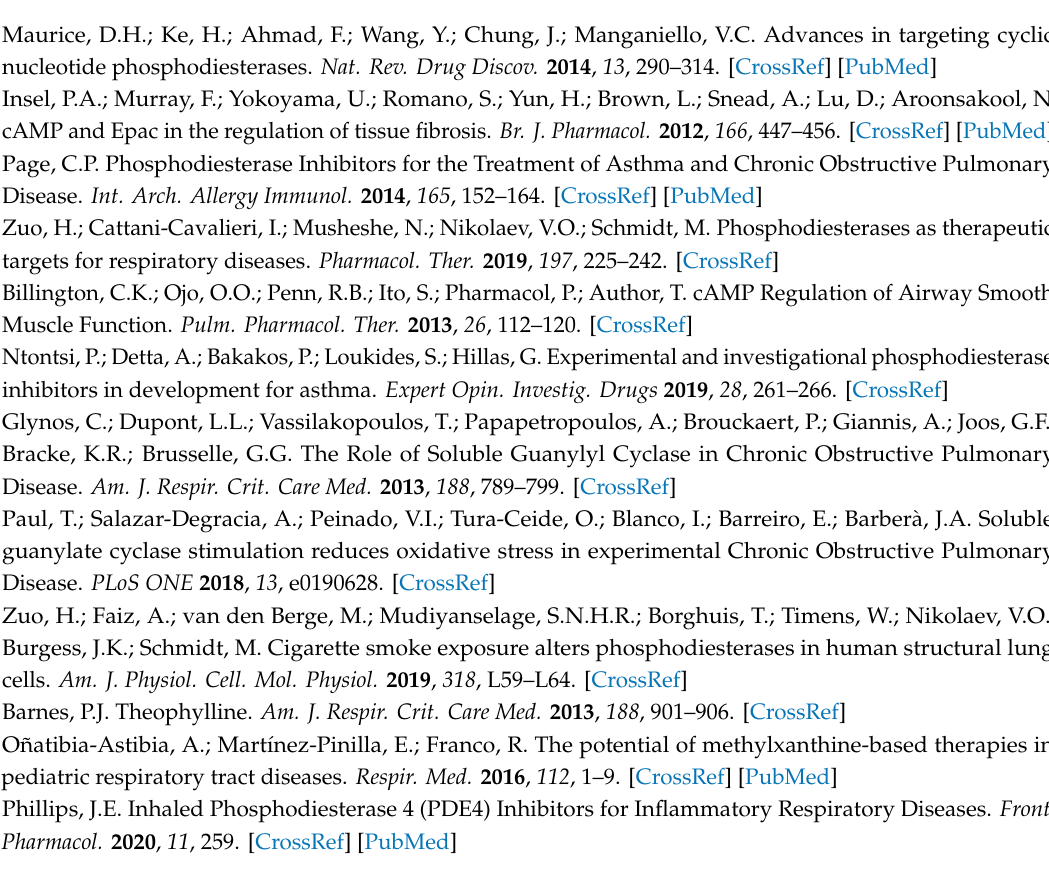
Table S1: MRC-5 proliferation in the growing concentrations of studied compounds. Values represent data presented on Figure 2B and Table S2: MRC-5 proliferation in the growing concentrations of studied compounds. Values represent data presented on Figure